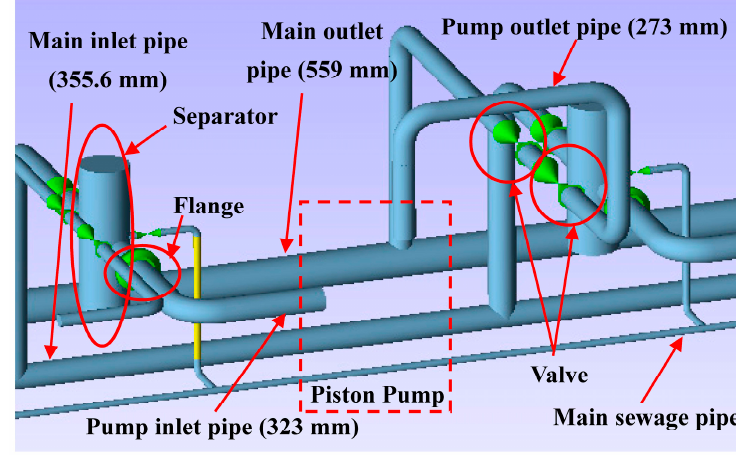
Figure 18. Partial magnification model.